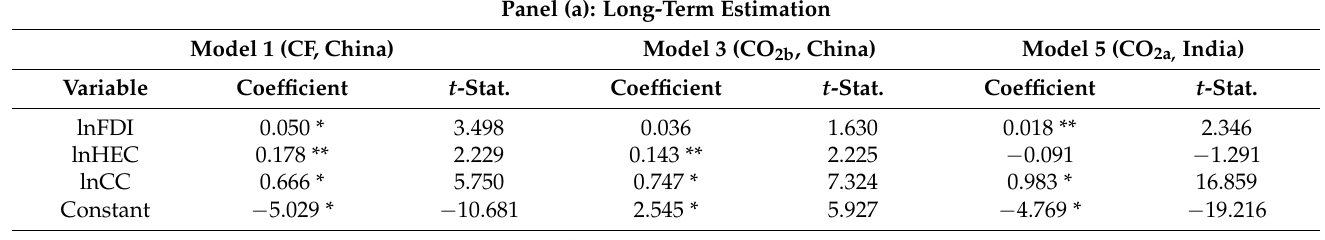
Table 6. Short- and long-term